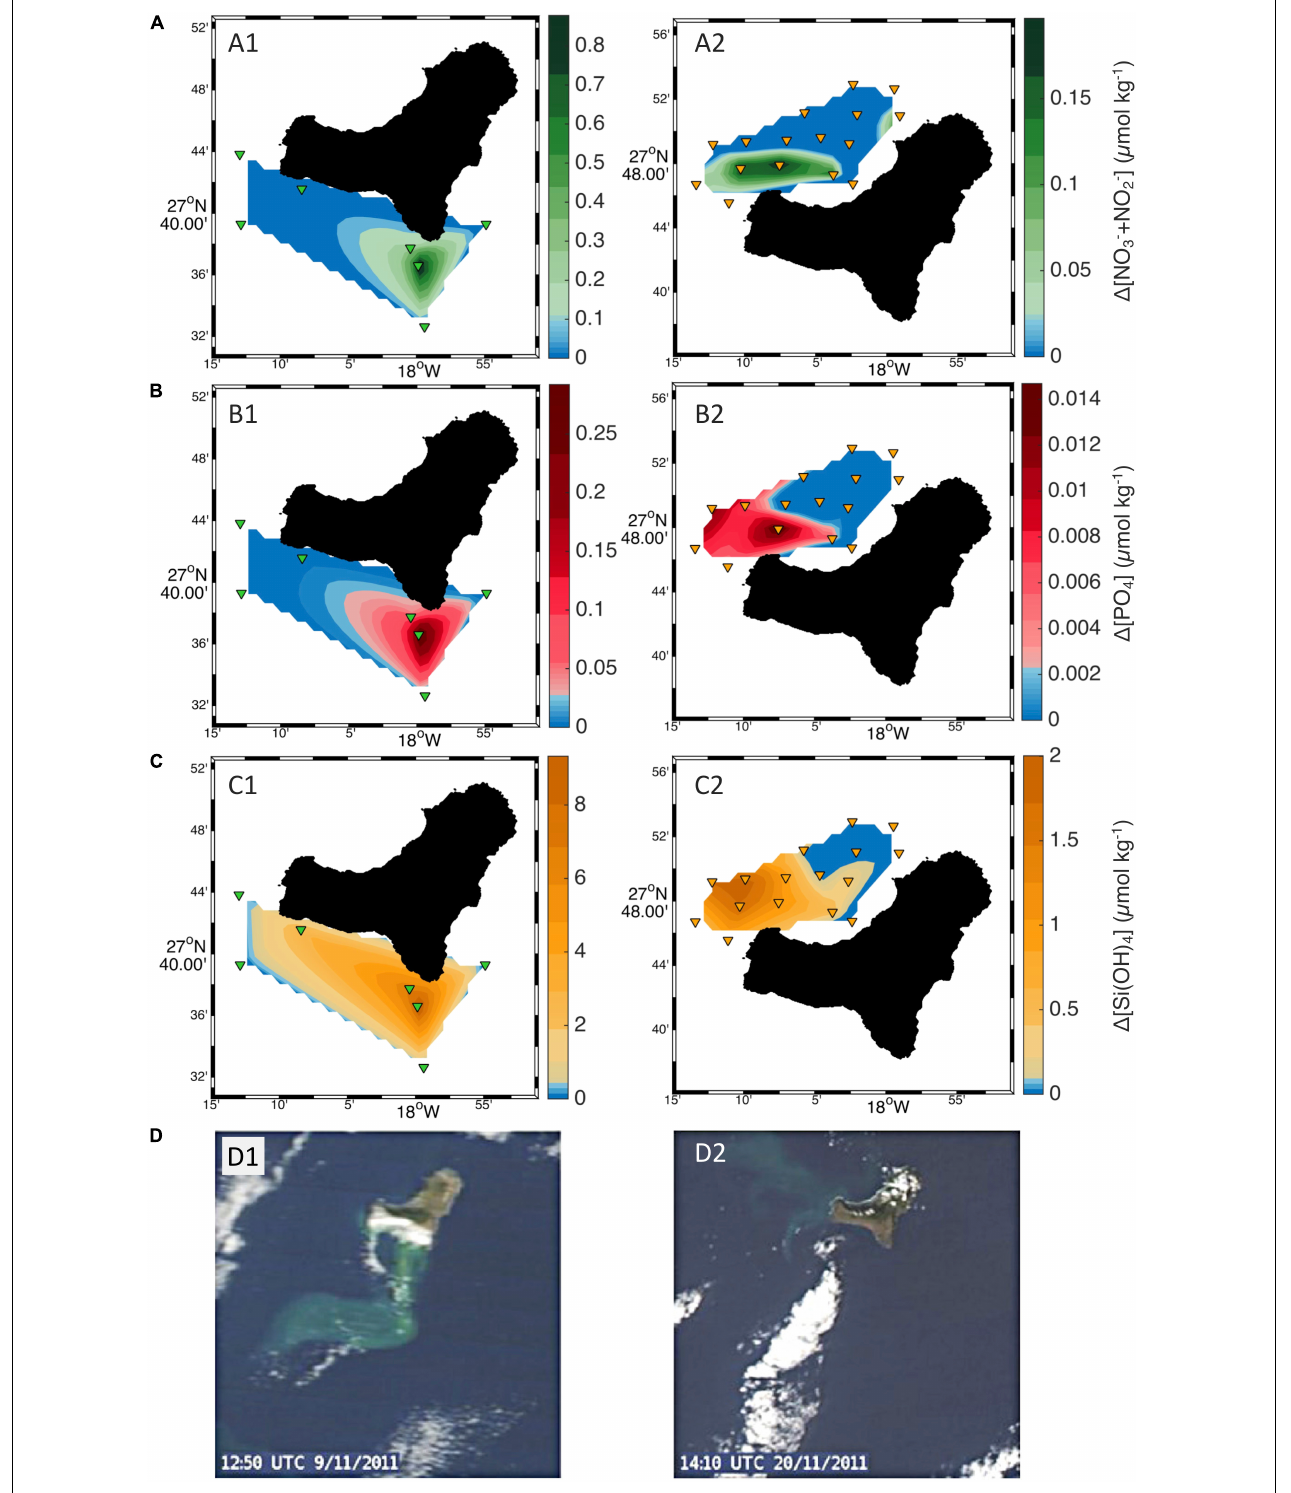
FIGURE 4 | Horizontal contours of nutrient anomalies for (A1, A2) nitrate, (B1, B2) phosphate, and (C1, C2) silicate in the eruptive stage, during cruises 1 and 2, respectively. The blue tones in the contours show anomalies below the standard deviation of the reference. (D) NASA MODIS RGB images of El Hierro island monitoring the eruptive event on (D1) November 9 and (D2) November 20, 2011. Note that the color of the plume is due to the chemicals injected by the volcano and not related to the accumulation of chlorophyll a in the water column (Eugenio et al.,